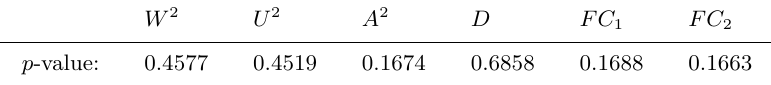
Table 5. Stress-rupture life: Goodness-of-fit tests. W 2 U 2 A 2 D FC 1 FC